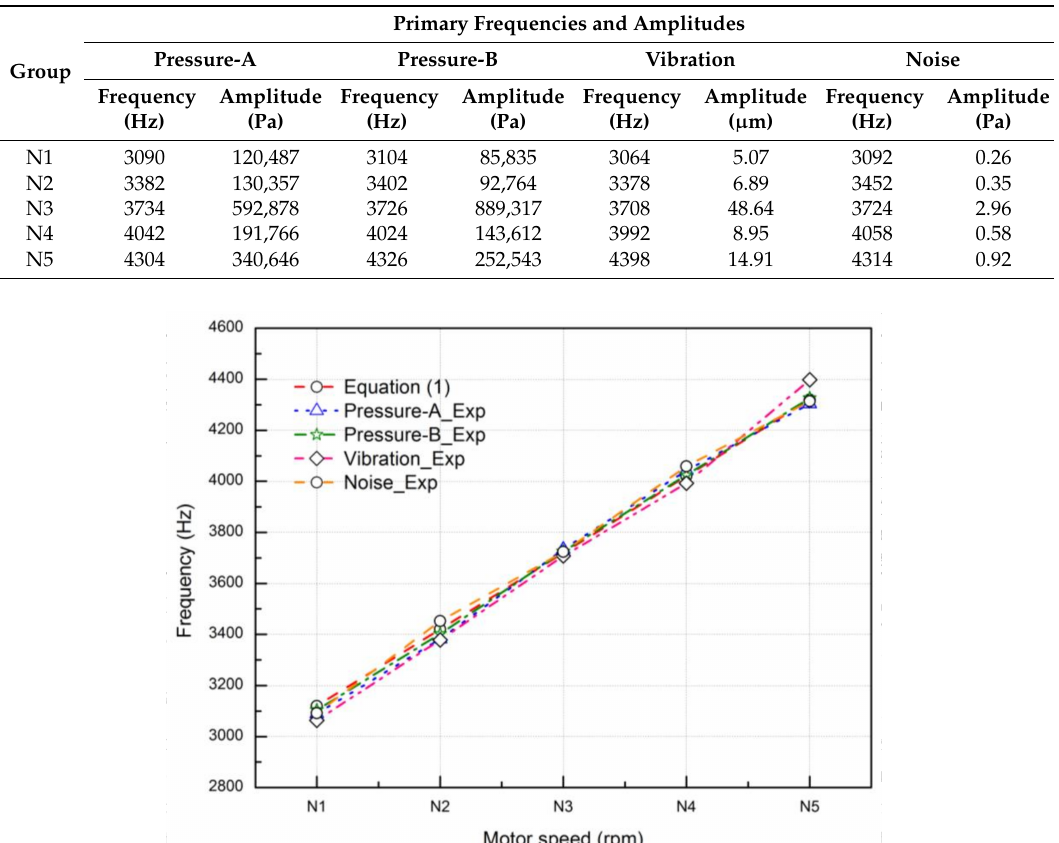
Table 6. Comparison of experimental results for the Type A flapper-armature assembly.